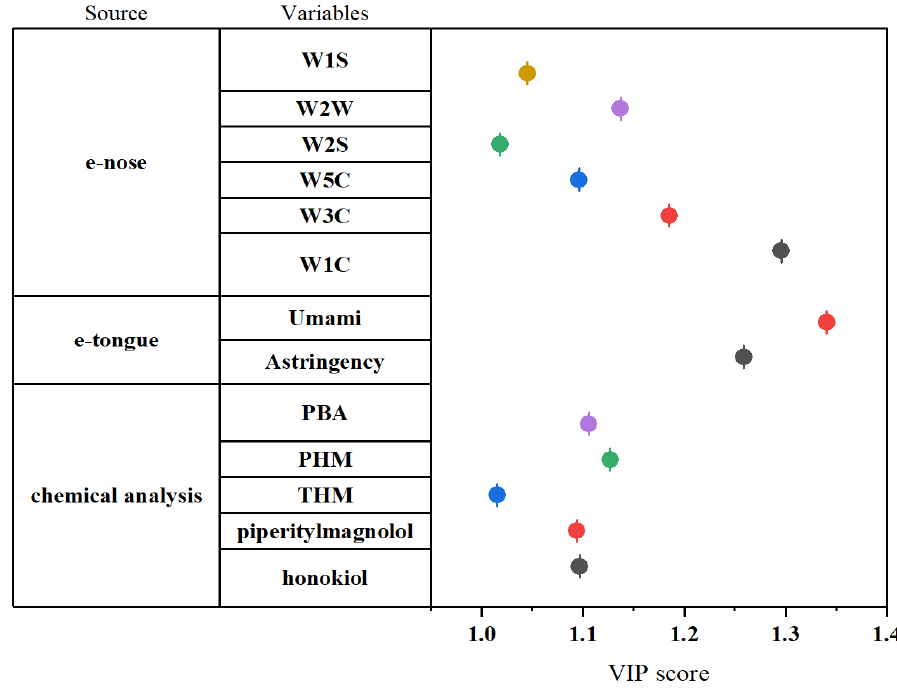
Figure 4. Selected variables with VIP score >1.0 from e-nose, e-tongue, and chemical analysis .